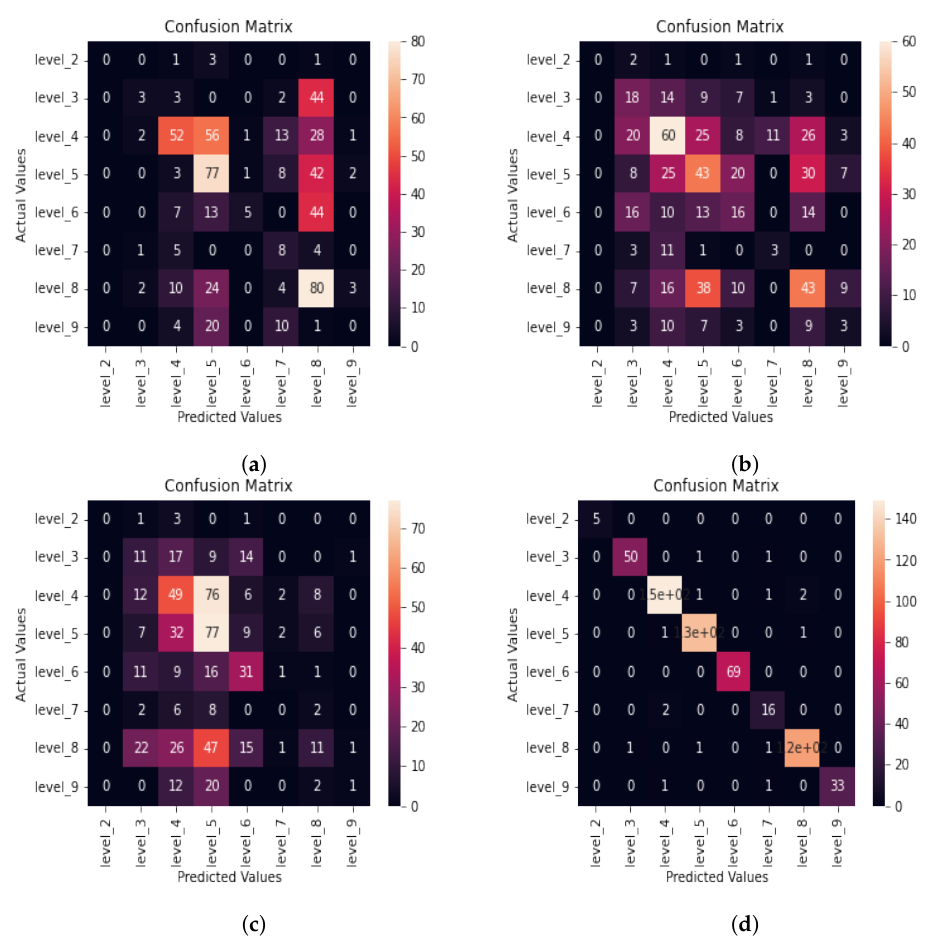
Figure 6. Confusion matrices of deep neural network for aphasia severity level classification using 10 s audio chunks for different speech feature extraction techniques. ( a ) Confusion matrix of DNN whose features have been extracted using mel-spectrogram. ( b ) Confusion matrix of DNN whose features have been extracted using chroma. ( c ) Confusion matrix of DNN with the zero crossing rate audio feature extracted. ( d ) Confusion matrix of DNN whose audio features are extracted using MFCC. Table 6. Classification report of DNN model for aphasia level classification using 10 s audio chunks whose features are extracted using mel-spectrogram. Aphasia Level Accuracy Precision Recall